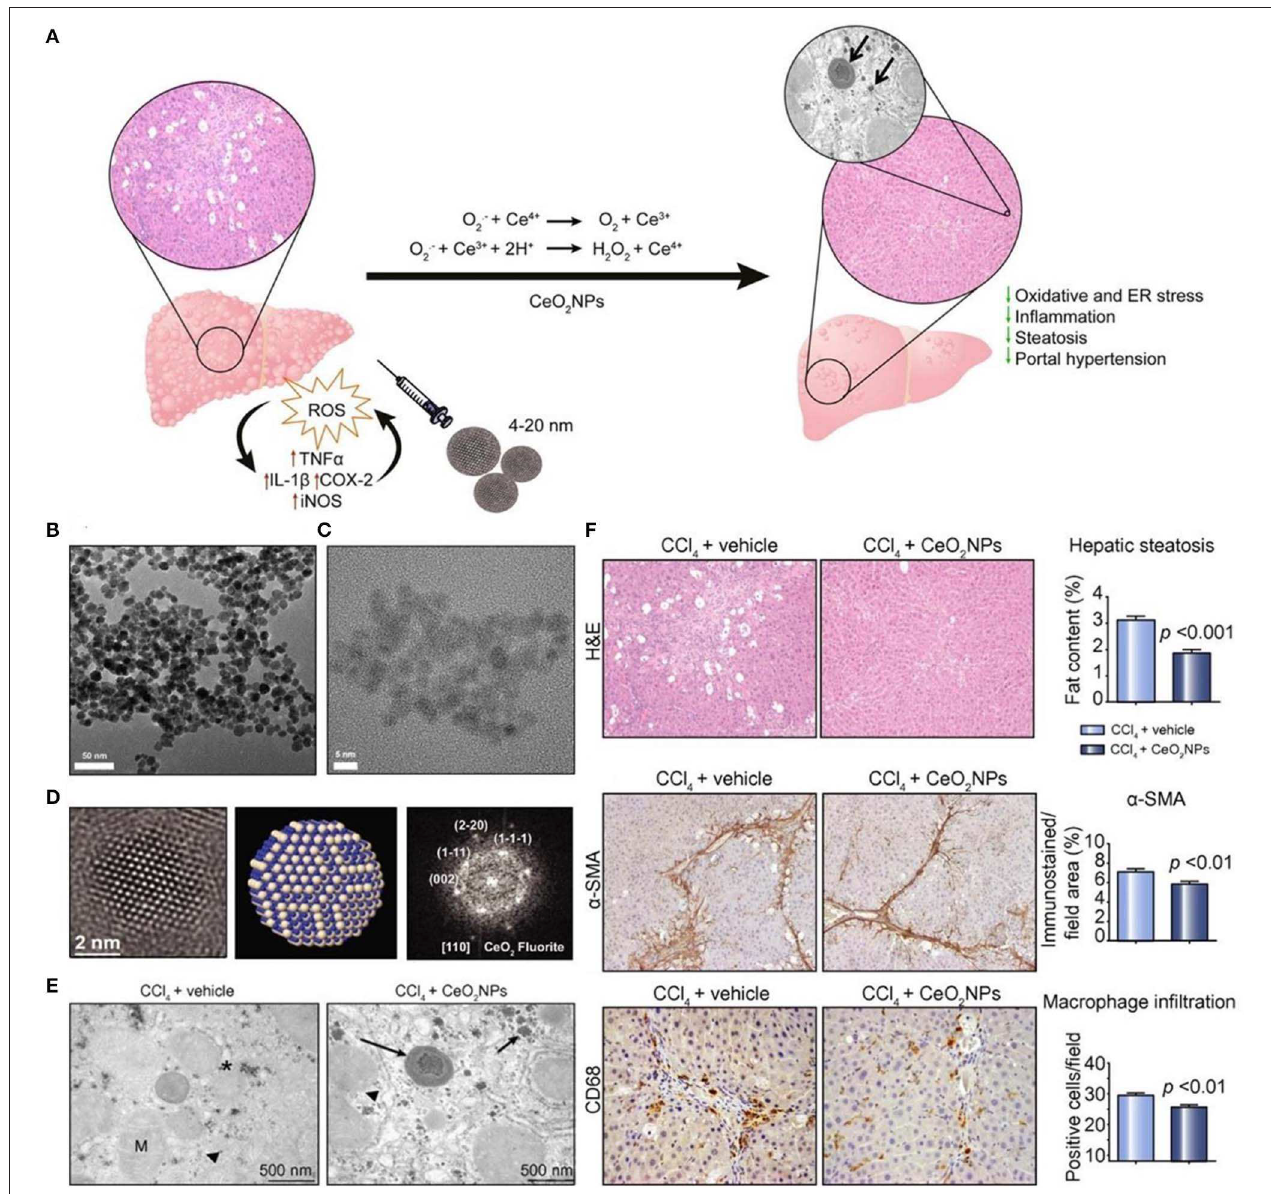
FIGURE 1 | Schematic, characterization, and in vivo evaluation of CeO 2 nanoparticles (NPs). (A) Schematic illustration of therapeutic mechanisms of CeO 2 NPs. (B) High-resolution transmission electron microscopy (HR-TEM) photomicrograph at low (43,000 × ) magnification revealing loose CeO 2 NPs agglomerates. (C) High magnification image (400,000 × ) of individual 4nm CeO 2 NPs with spherical shape. (D) (Left) The HR-TEM image of single CeO 2 NP showing the spherical morphology; (middle) atomistic simulation of CeO 2 NP with a characteristic fluorite-like electronic structure; (right) FFT of the selected nanoparticle with indicated atomic planes. (E) TEM image of liver tissue obtained from a CCl 4 -treated rat receiving vehicle and a CCl 4 -treated rat receiving CeO 2 NPs. Hepatocyte intracellular space containing mitochondria (M), organelles, fat droplets (asterisk), glycogen inclusions (arrow head), and aggregates of CeO 2 NPs (arrows). (F) Effect of CeO 2